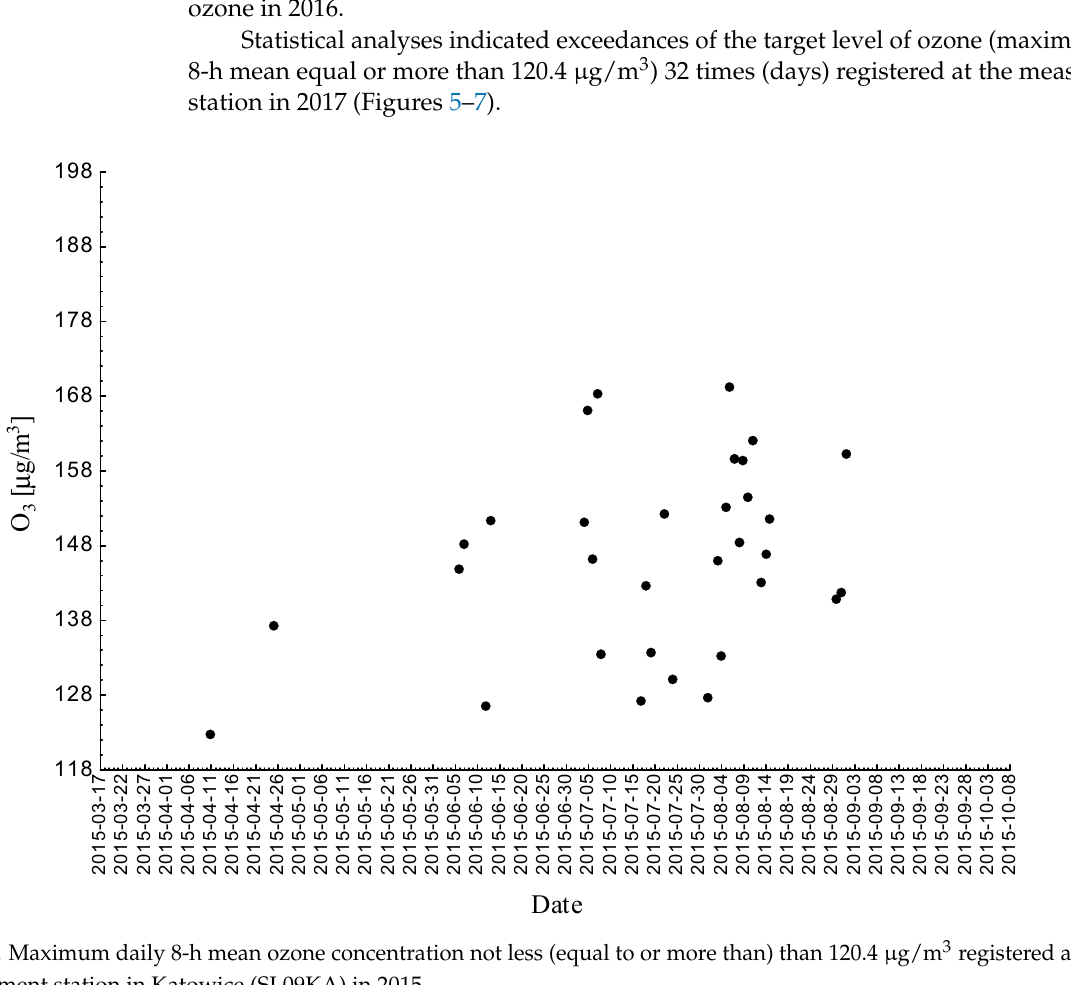
Figure 6. Maximum daily 8-h mean ozone concentration not less (equal to or more than) than 120.4 µg/m 3 registered at the measurement station in Katowice (SL09KA) in 2016.